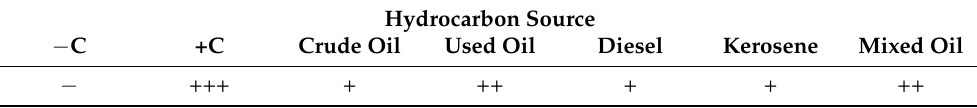
Table 3. Drop-collapse test to liquid contains surfactants from different strain of D. spicifera